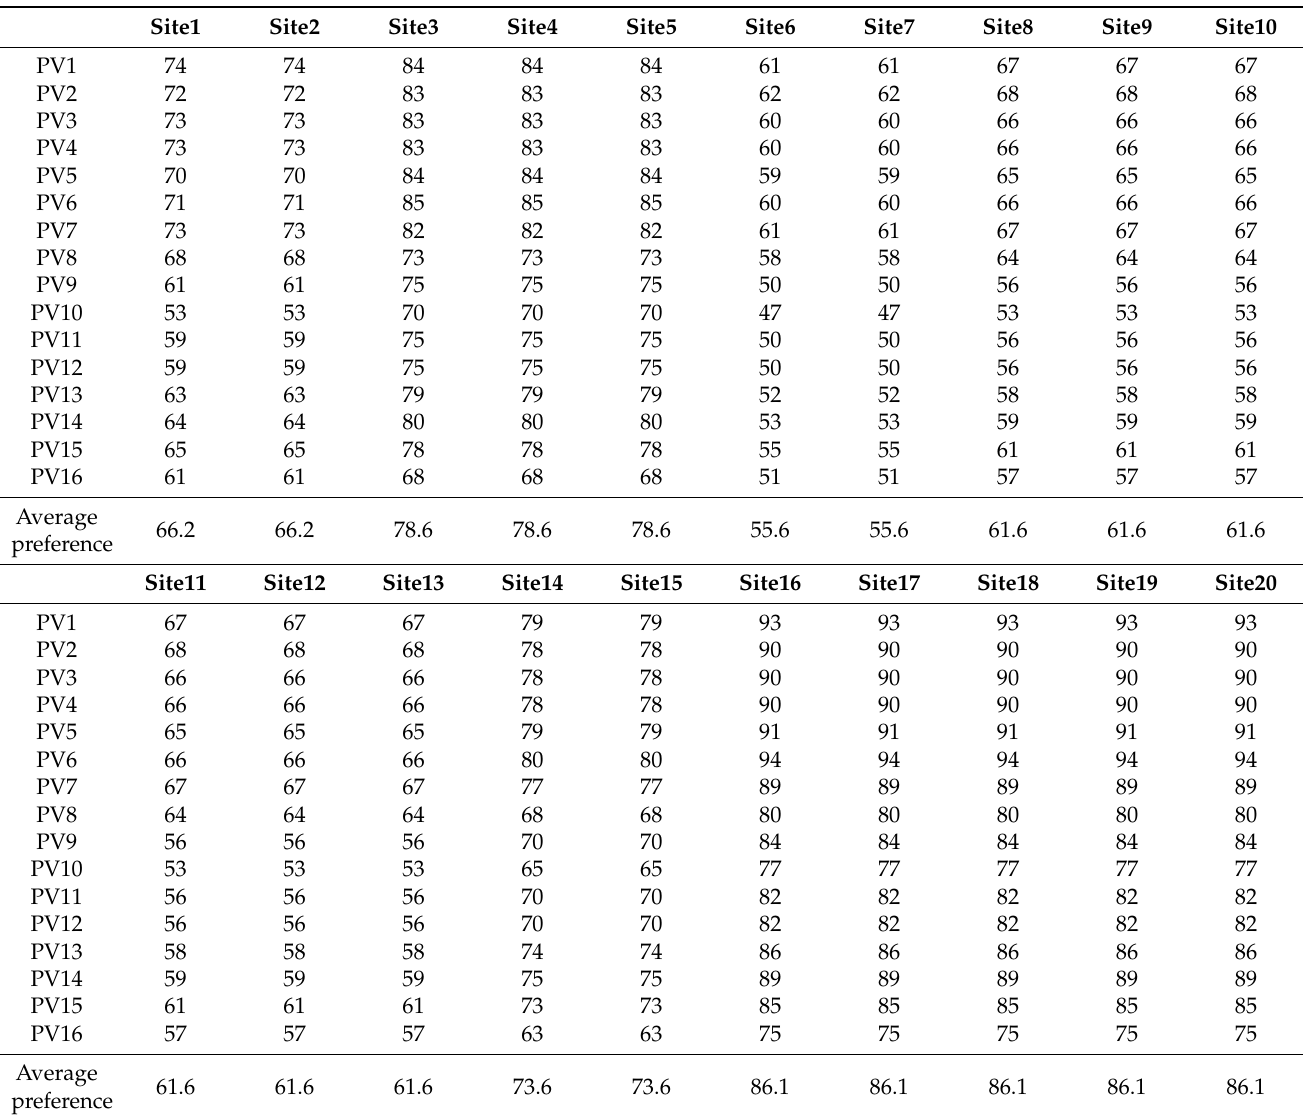
Table 3. Assumptions of levels of preferences of stakeholders. Local people’s levels of preferences for PV specifications for each